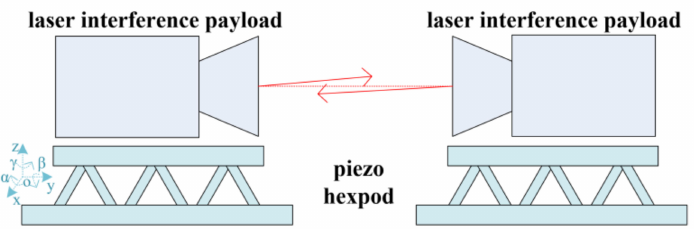
Figure 6. Technical solution for the semi-physical simulation test for the establishment of inter- satellite laser links.